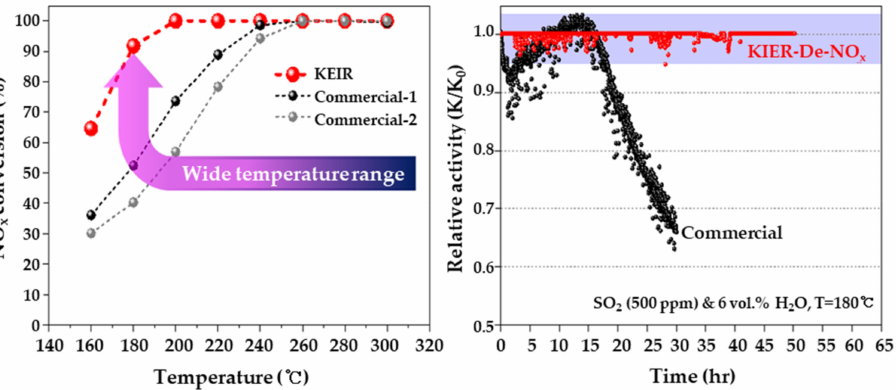
Figure 15. KIER catalytic activity and SO x resistance over a wide temperature range (reprinted from [39] under the Creative Commons Attribution 4.0